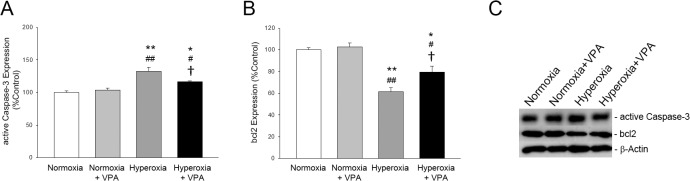
Bar graphs depicting active Caspase-3 (A) and bcl2 (B) expressions in lung tissues of rat pups.Panel C depicts representative bands for each protein, including β-Actin, the protein which was used as a loading control for western blotting. *p<0.05 and **p<0.001 compared to Normoxia group; #p<0.05 and ##p<0.001 compared to Normoxia+VPA group; and †p<0.05 compared to Hyperoxia group using One-Way ANOVA followed by post-hoc Tukey test.